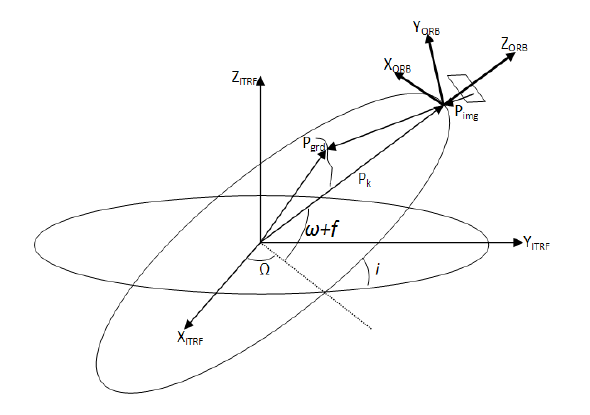
Figure 1. Geometrical relationship between image and ground